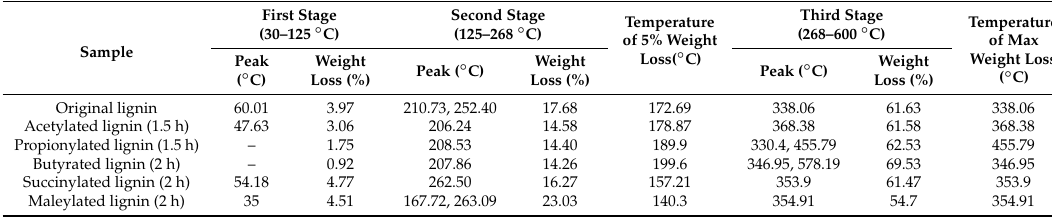
Table 1. TGA characteristic